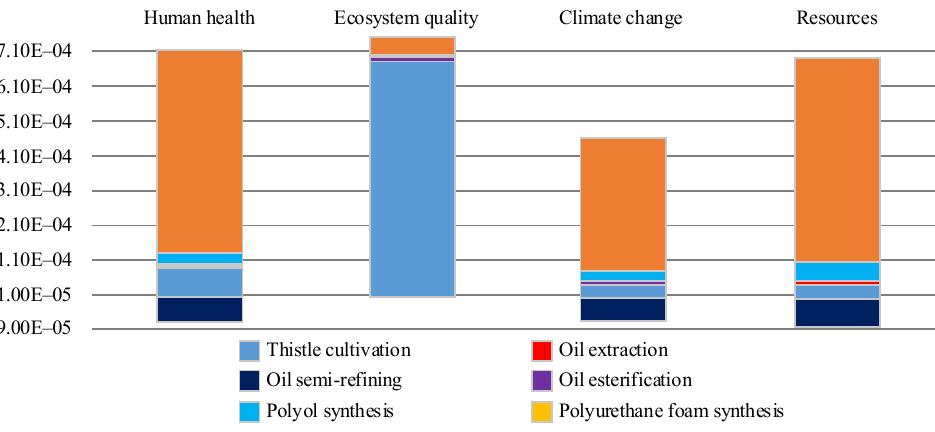
Fig. 3. IMPACT 2002+ normalized endpoint damage categories for the production of 1 kg rigid polyurethane foam. Looking towards the results presented after the normalization (Fig. 3), Ecosystem quality and Human health are those impact categories with higher values. Land use is responsible for more than 90 % of the overall impact in the Ecosystem quality. This represents an change probably play relevant part. In fact, it was considered that the cultivation was not made on already existing agricultural